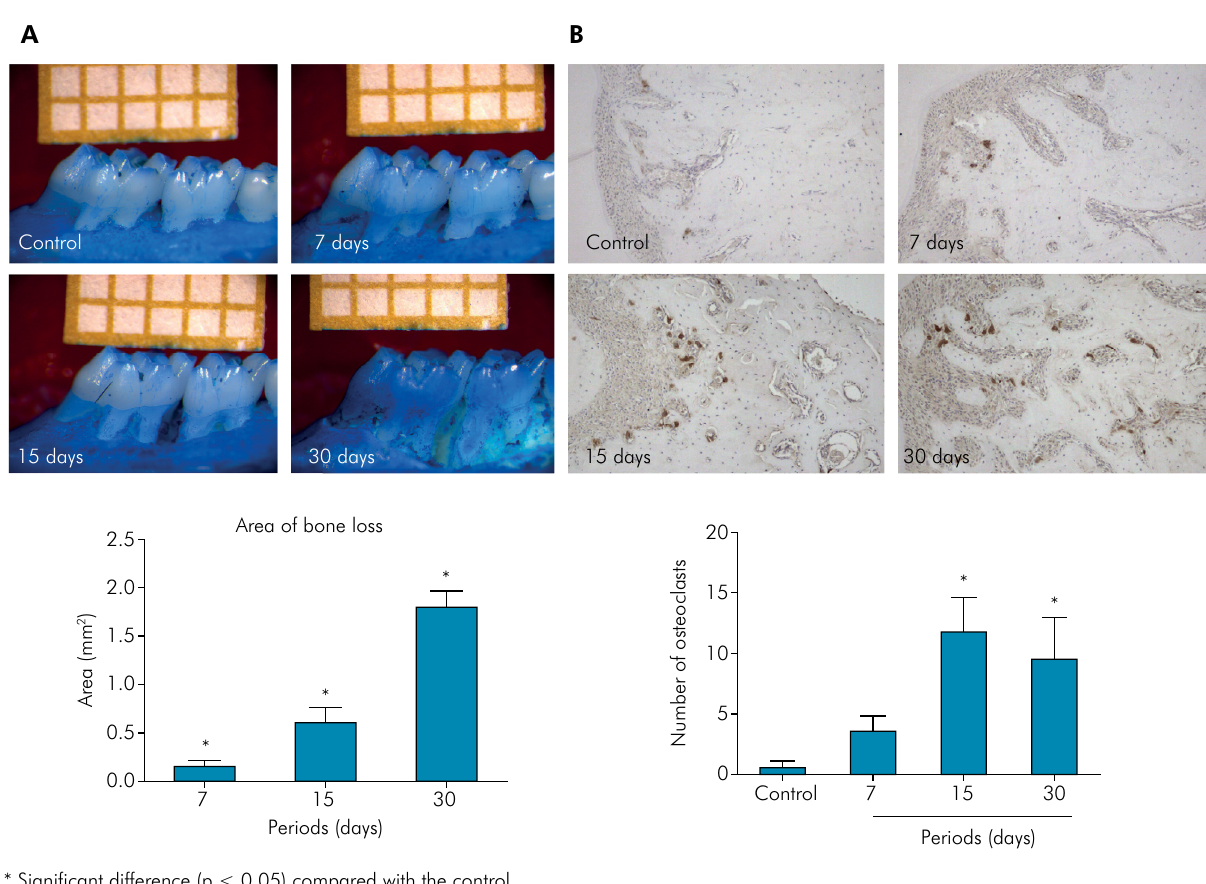
Figure 2. (A) The area of bone loss at the palatal surface of the first molar was measured macroscopically. Samples stained with methylene blue are shown for each group. The graph with average ± standard deviation demonstrated that increased bone loss occurred as early as 7 days, followed by a significant increase after 15 and 30 days. (B) Representative images (×100 magnification) of immunohistochemical staining for TRAP showing osteoclasts in tissue sections from the control and experimental groups. The graph revealed increases in osteoclast counts throughout the 30-day experimental period, peaking at 15 days, in comparison to the control group